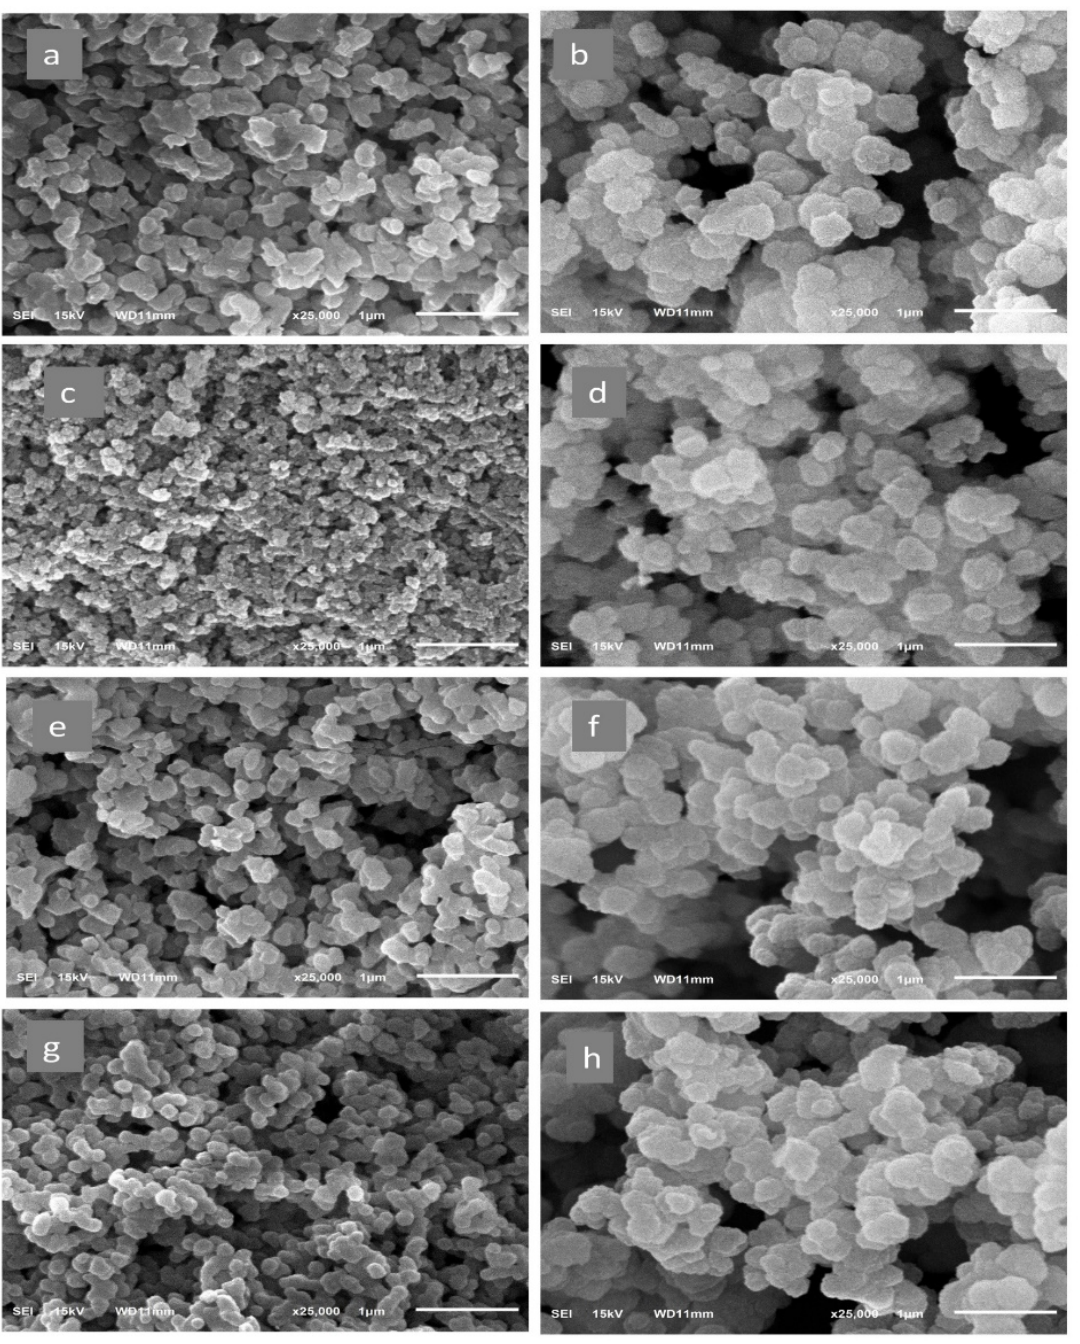
Figure 10. Scanning electron microscope images of ( a ) MIP1, ( b ) NIP1, ( c ) MIP2, ( d ) NIP2, ( e ) MIP3, ( f ) NIP3, ( g ) MIP4, and ( h ) NIP4.